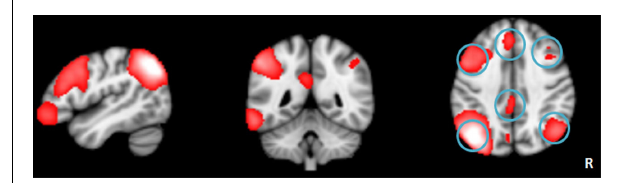
Table 1 | The left frontoparietal network